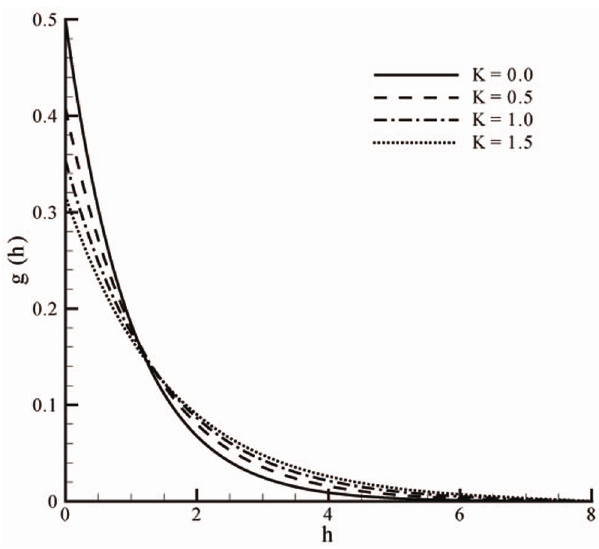
Figure 4. Influence of K on microrotation profile g ( g ) when n ~ 0 : 0 :